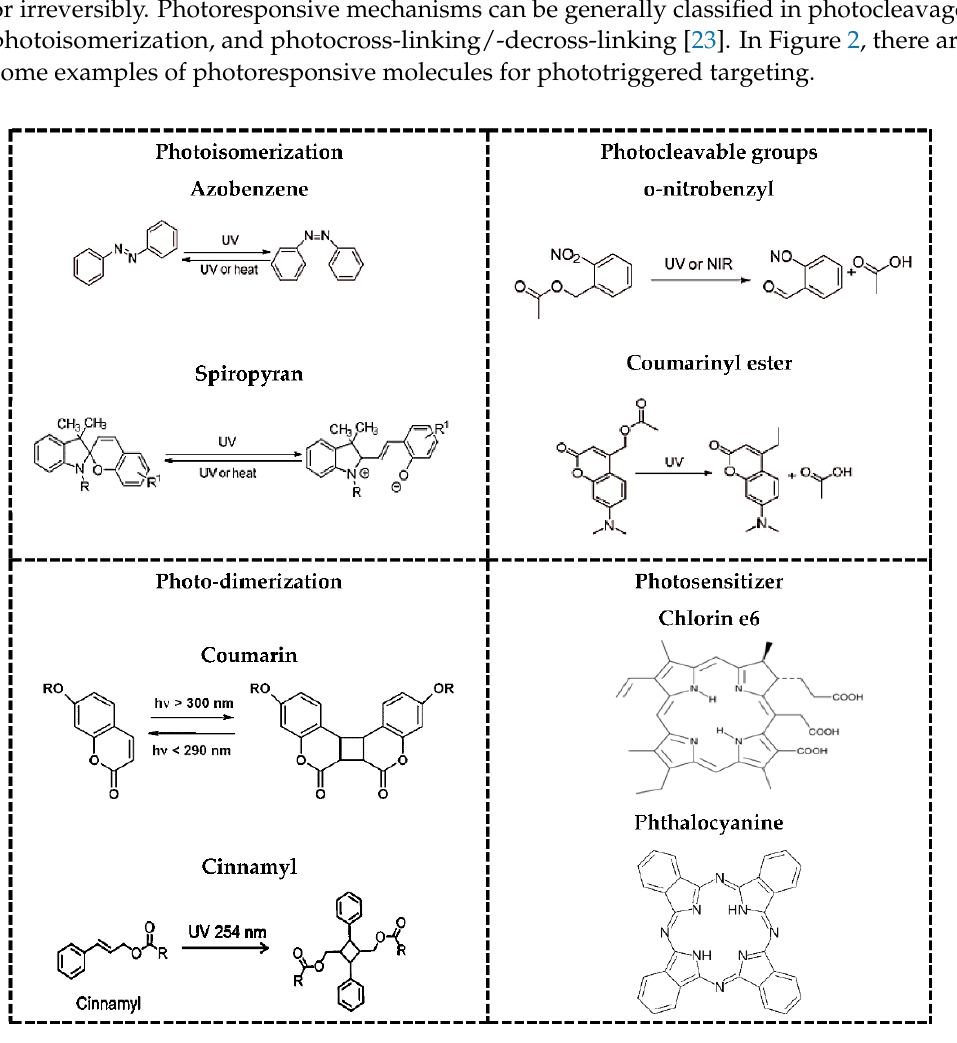
Figure 2. Photoresponsive molecules for phototriggered drug release.